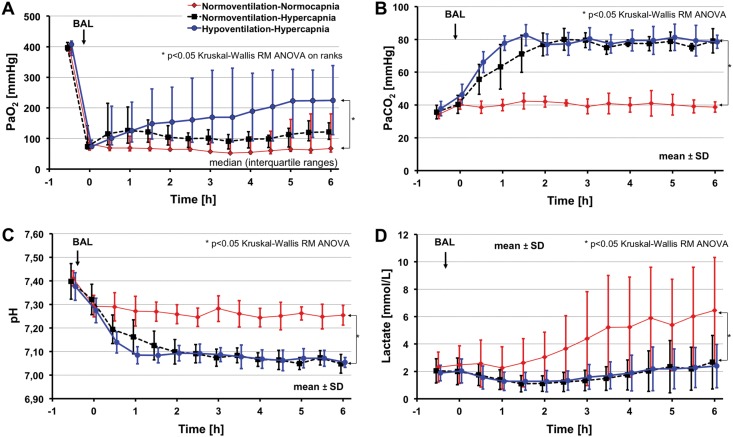
Gas exchange (PaO2 [A], PaCO2 [B]) and acid base characteristics (pH [C], lactate [D]) over experimental time.Time = 0 refers to time of randomization. BAL = bronchoalveolar lavage. PaO2 was significantly higher in the HH- vs. the NN-group. Arterial pH and lactate were lower in both hypercapnia groups as compared to the NN-group; * = p< 0.05.